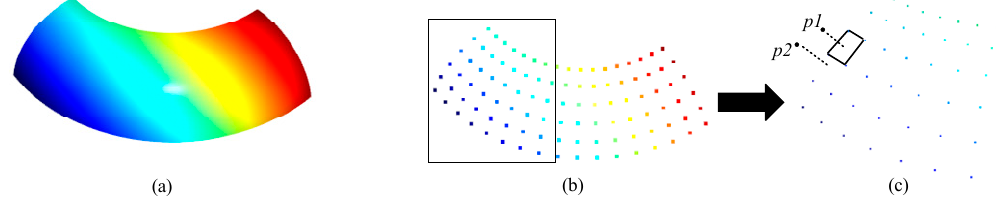
Figure 10. The judgement of whether a point belongs to a curved surface. ( a ) Curved surface; ( b ) Down-sample of point cloud; ( c ) The relation of points and quadrilateral plane.